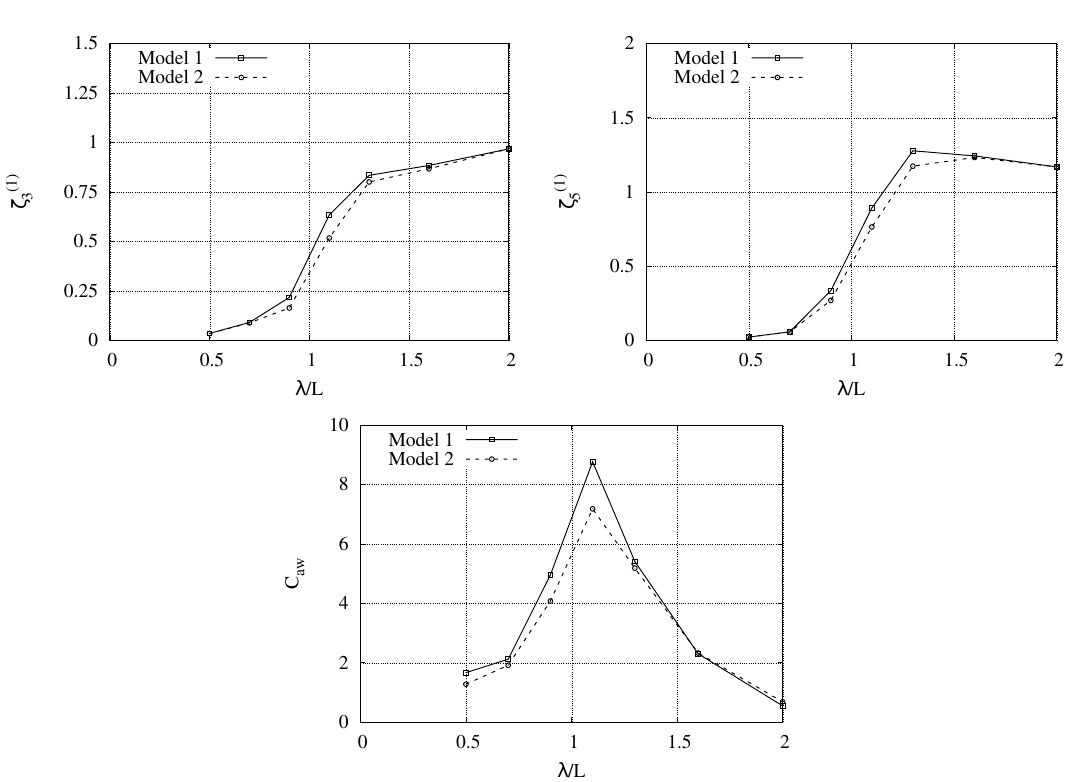
Figure 13. Profiles of heave, pitch and added resistance of the two models against λ / L